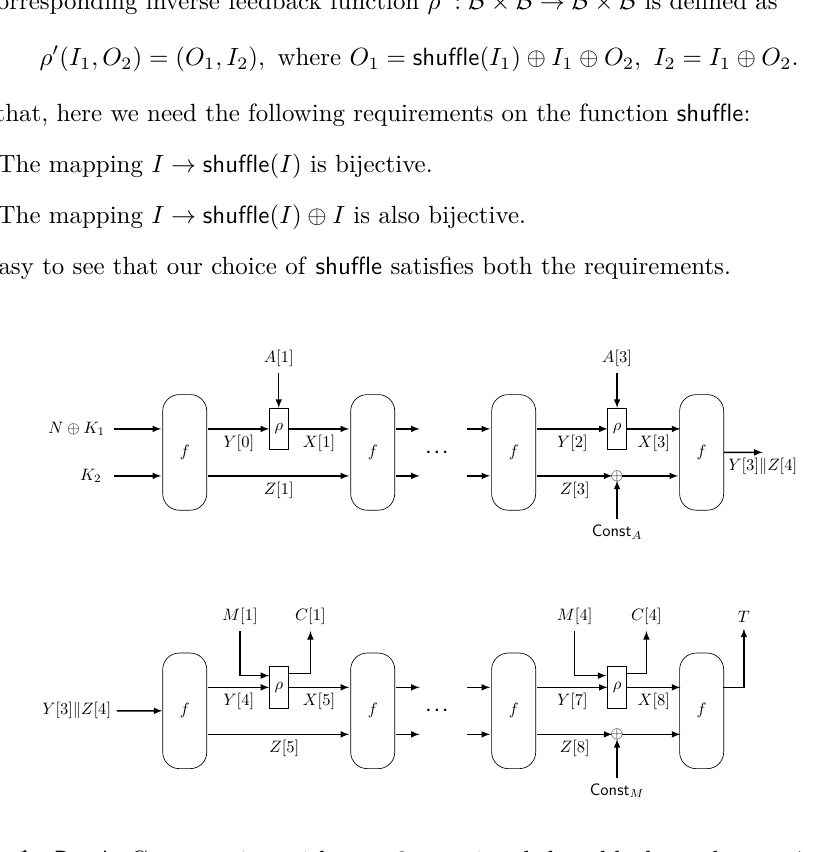
Figure 1: Beetle Construction with a = 3 associated data blocks and m = 4 message blocks. The value Const A and Const M is used to denote whether last associated data block and message block is complete or